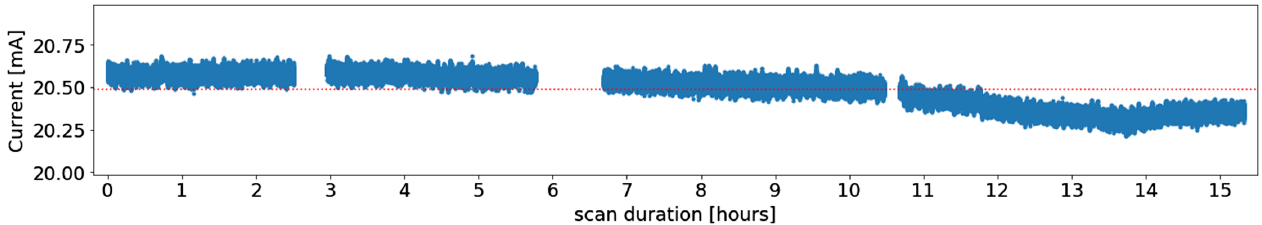
FIG. 18. Output at beam current monitor during collection of results shown above. Red dashed line indicates average over scan of 20.48 mA. Pauses are due to routine lock-outs of BTF